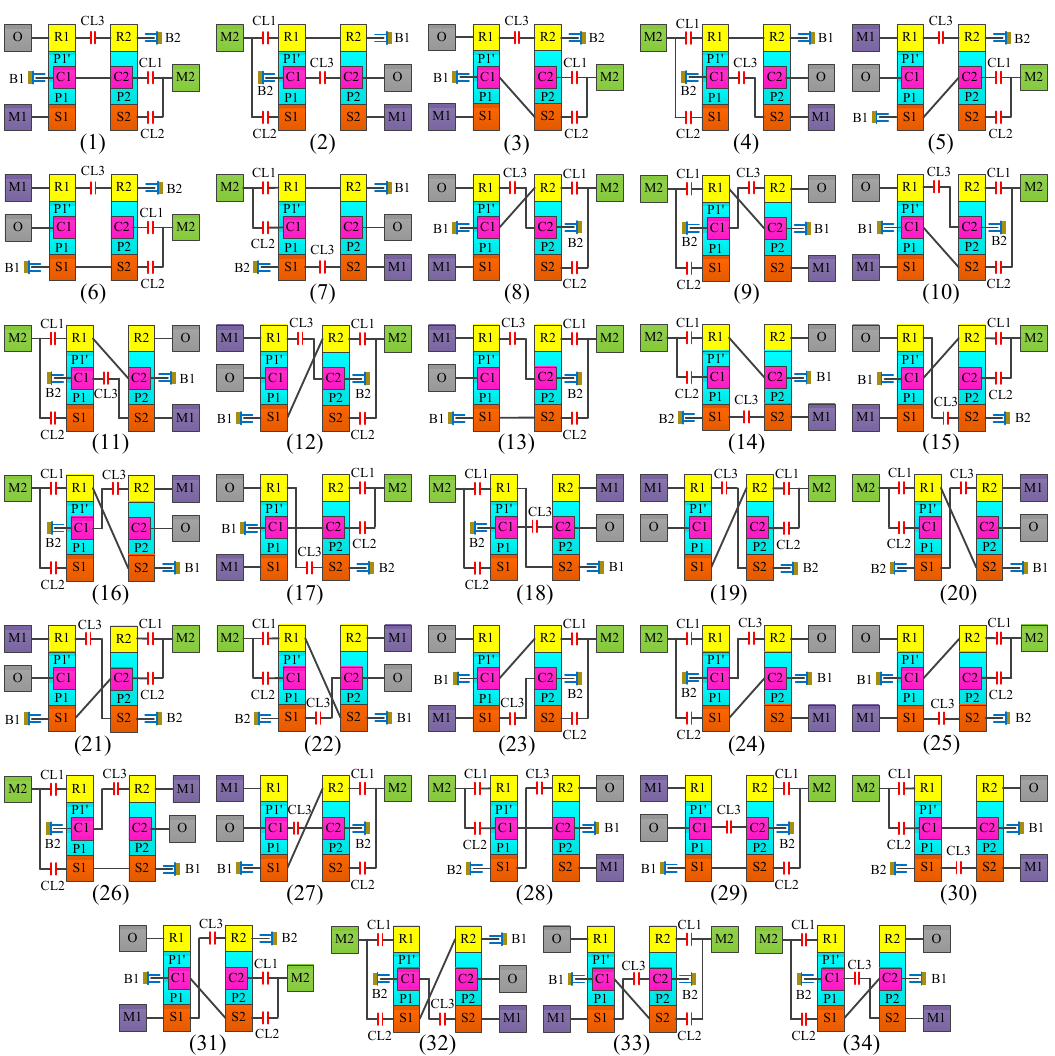
Figure 8. The atlas of the new motor transmissions.